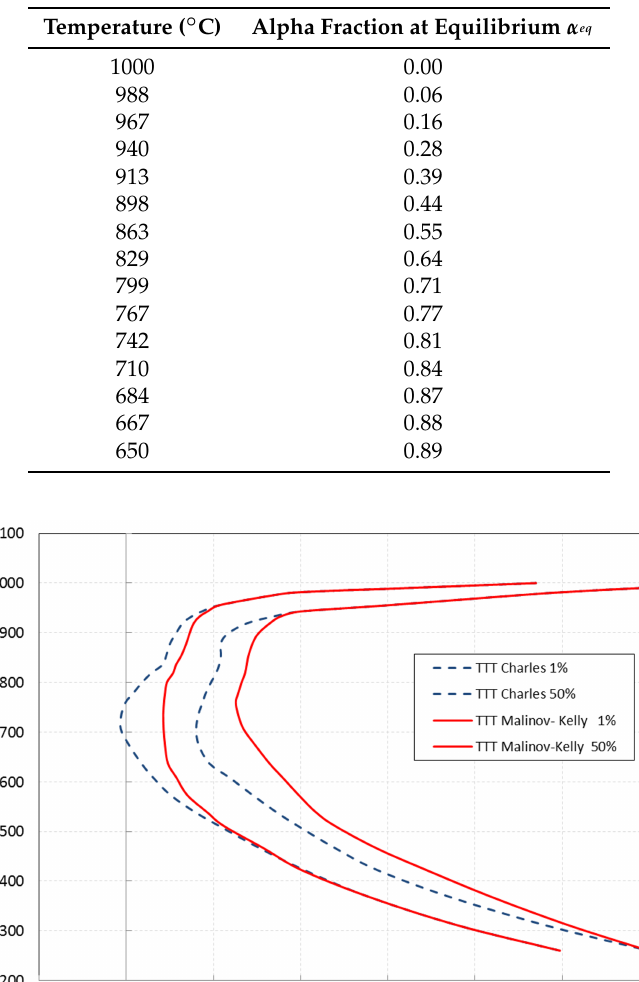
Table 1. Alpha fraction at equilibrium at different temperatures: maximum final fraction of alpha phase that can form at equilibrium at temperature T according with the phase diagram of the alloy.